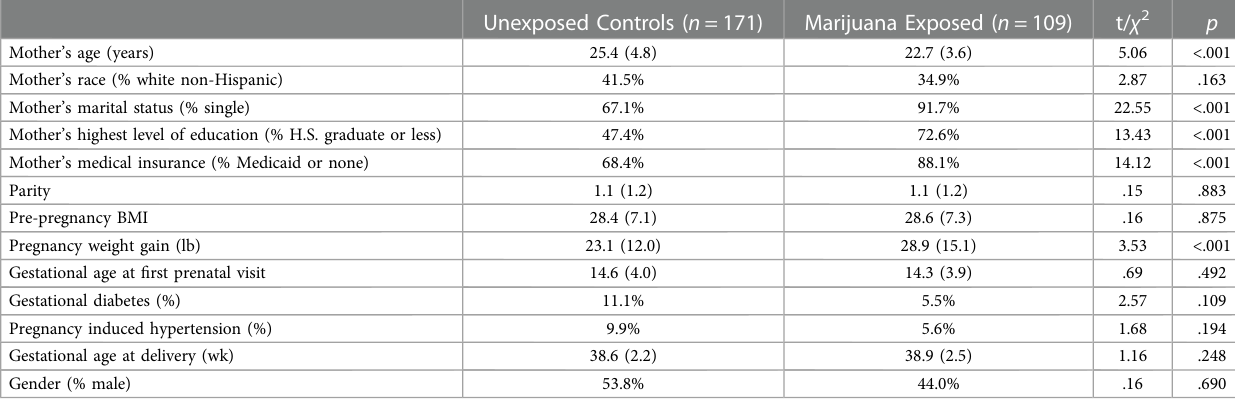
TABLE 1 Participant characteristics by marijuana exposure